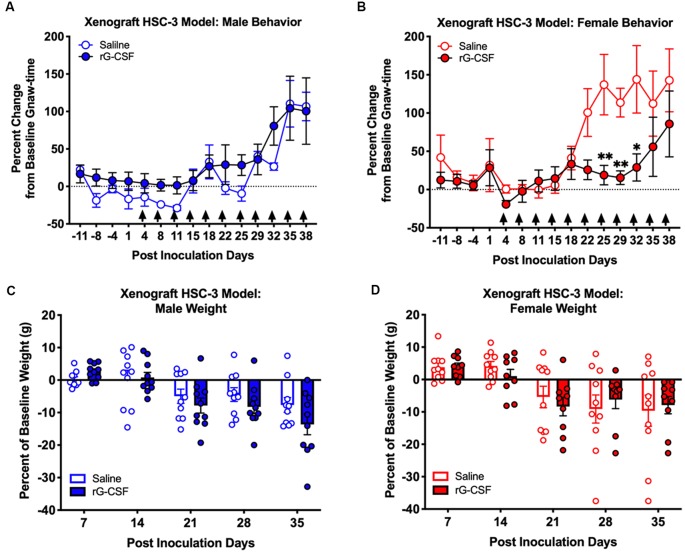
HSC-3 xenograft-induced change in orofacial nociceptive behavior was measured in adult nude male (A) and female (B) mice receiving saline (N = 10, open circles) or rG-CSF treatment (2.5 μg/mouse, N = 10, closed circles) 24 h prior to each dolognawmeter measurement, as indicated by the black arrows. Sexes were independently analyzed. Two-way ANOVA, *P < 0.05, **P < 0.01. HSC-3 xenograft-induced weight loss was measured in male (C) and female (D) mice receiving saline (N = 10, open bars) or rG-CSF (2.5 μg/mouse, N = 10, closed bars) each week.